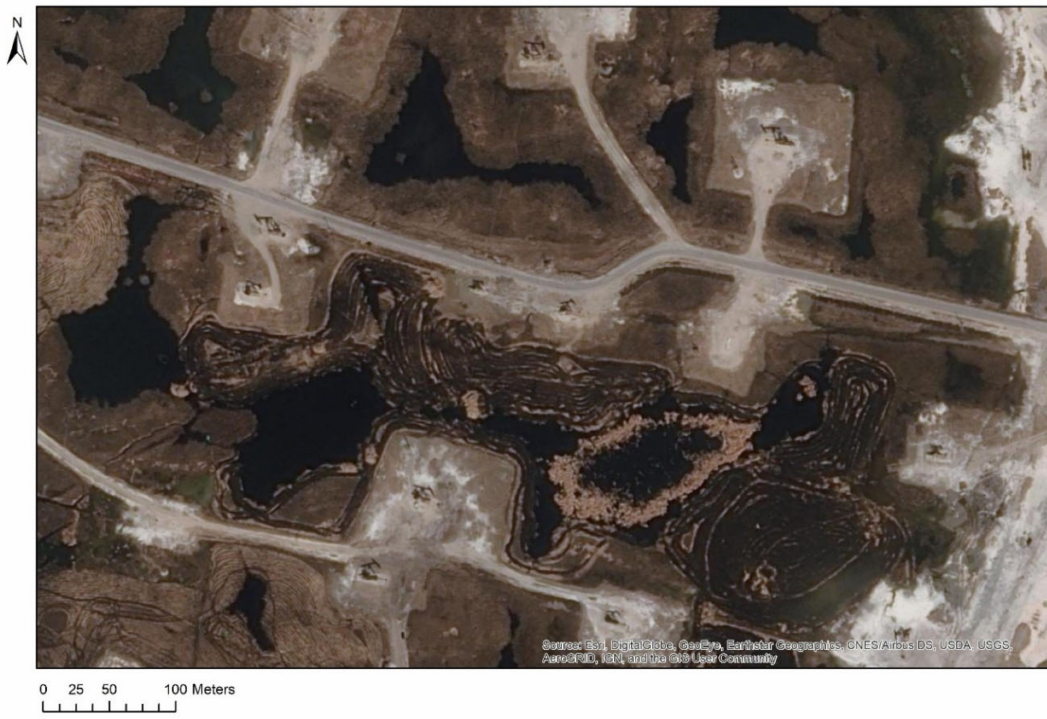
Figure 5. One of the numerous areas of the oil field of Daqing where oil derricks can be identified on the satellite image. Picture from the World Imagery of